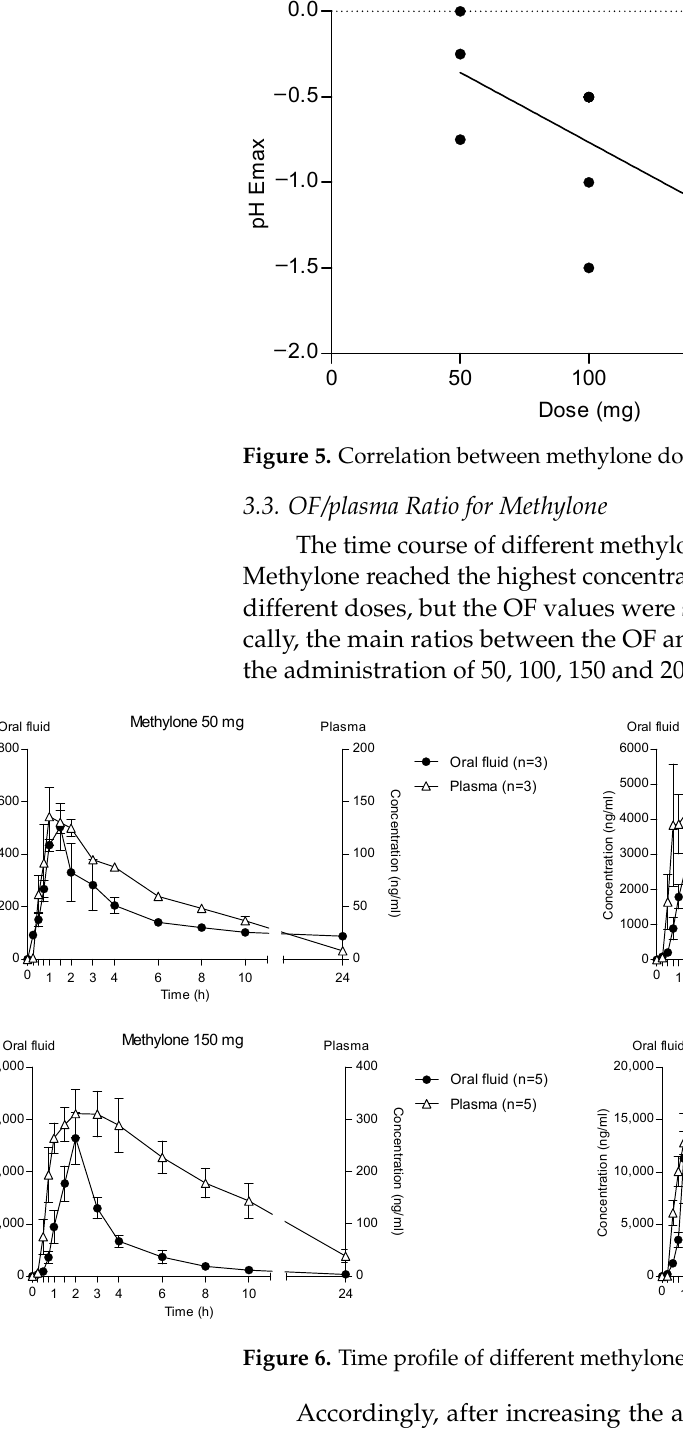
Figure 6. Time pro fi le of di ff erent methylone concentrations in OF and plasma. Accordingly, after increasing the administered methylone doses, the ratio the 24 h OF/P ratio exhibited mean maximum values of 20.7, 46.0 and 31.8 at 2 h (corresponding to the t max ) after 100, 150 and 200 mg methylone, respectively, while after 50 mg dose the highest OF/P was 11.8 at 24 h (Figure 7). The p -value was <0.0001 for each administration.